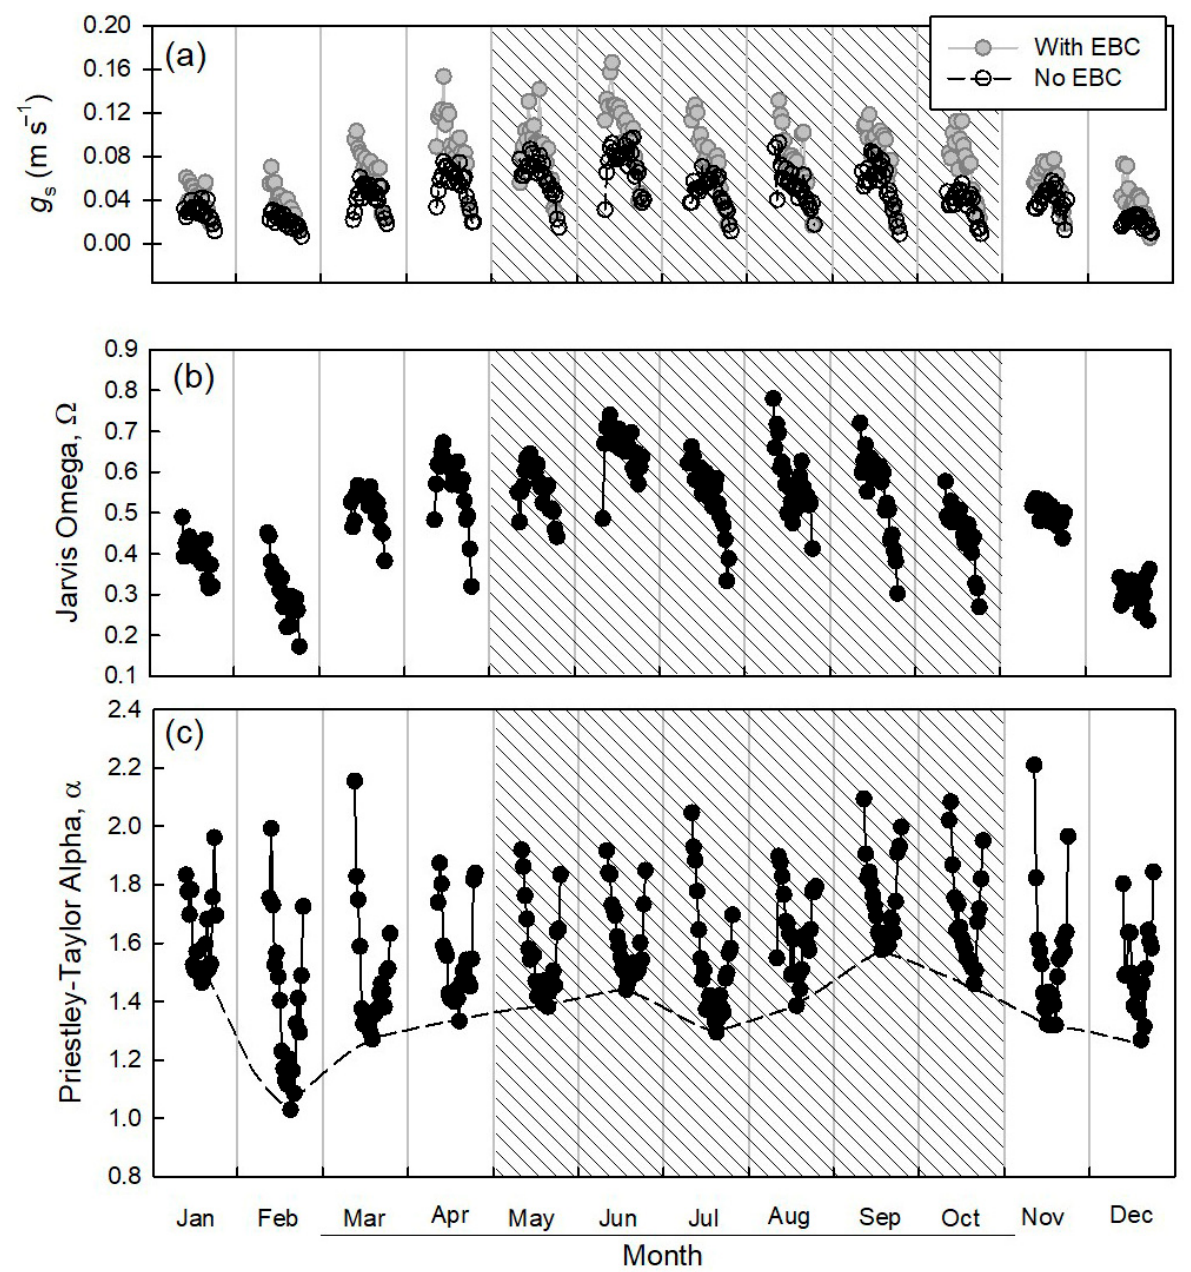
Figure 10. The monthly mean diurnal variation of the surface conductance ( a , g s ), Jarvis Omega ( b , Ω ) and Priestley–Taylor Alpha ( c , α ). The g s value was also calculated after energy imbalance correction, which is shown as EBC. The shaded area indicates the wet season (May through October).